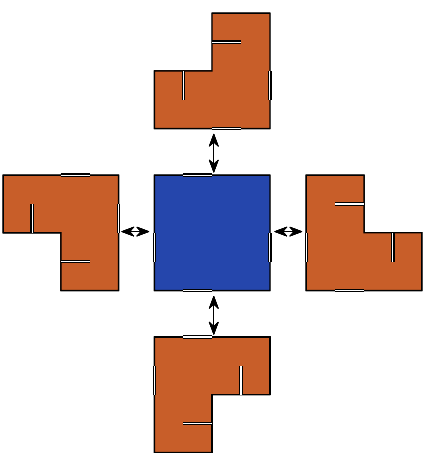
Figure 2. The information flow between five adjacent buildings for the proposed swarm-based parallel control (SPC) (plan view).